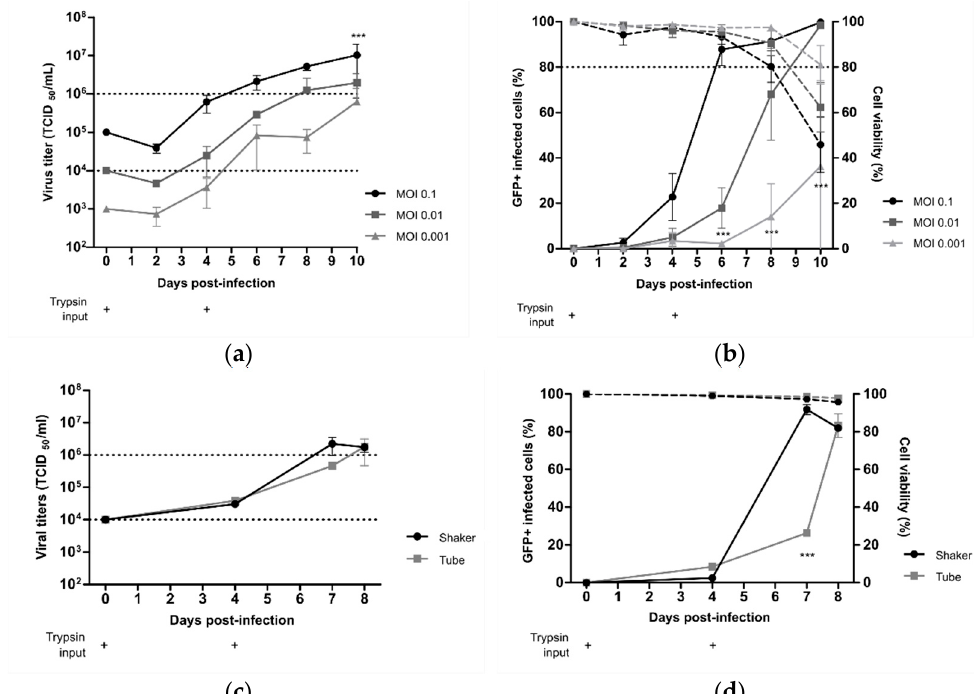
Figure 3. Viral kinetics of live-attenuated vaccine candidate Metavac ® in DuckCelt ® -T17 cell line. On the basis of identified optimal production parameters, cells were seeded at 1 × 10 6 cell/mL and infected, and trypsin was added at 0.5 µg/mL on D0 and D4 (+). Culture parameters in a 10 mL working volume were separately evaluated by ( a , c ) viral titration, and ( b , d ) viability and infectivity measurement; dotted line for cell viability and solid line for infectivity. ( a , b ) Evaluation of viral kinetics and cell infectivity for an MOI of 0.1, 0.01, or 0.001 in a 10 mL working volume. ( c , d ) Evaluation of viral kinetics and cell infectivity when cells were seeded in a 500 mL (shaker) or 10 mL (tube) working volume and infected at an MOI of 0.01. Results shown as means ± SD and represent duplicates in two independent experiments. *** p < 0.001 when comparing infected conditions to each other using a two-way repeated-measures ANOVA.